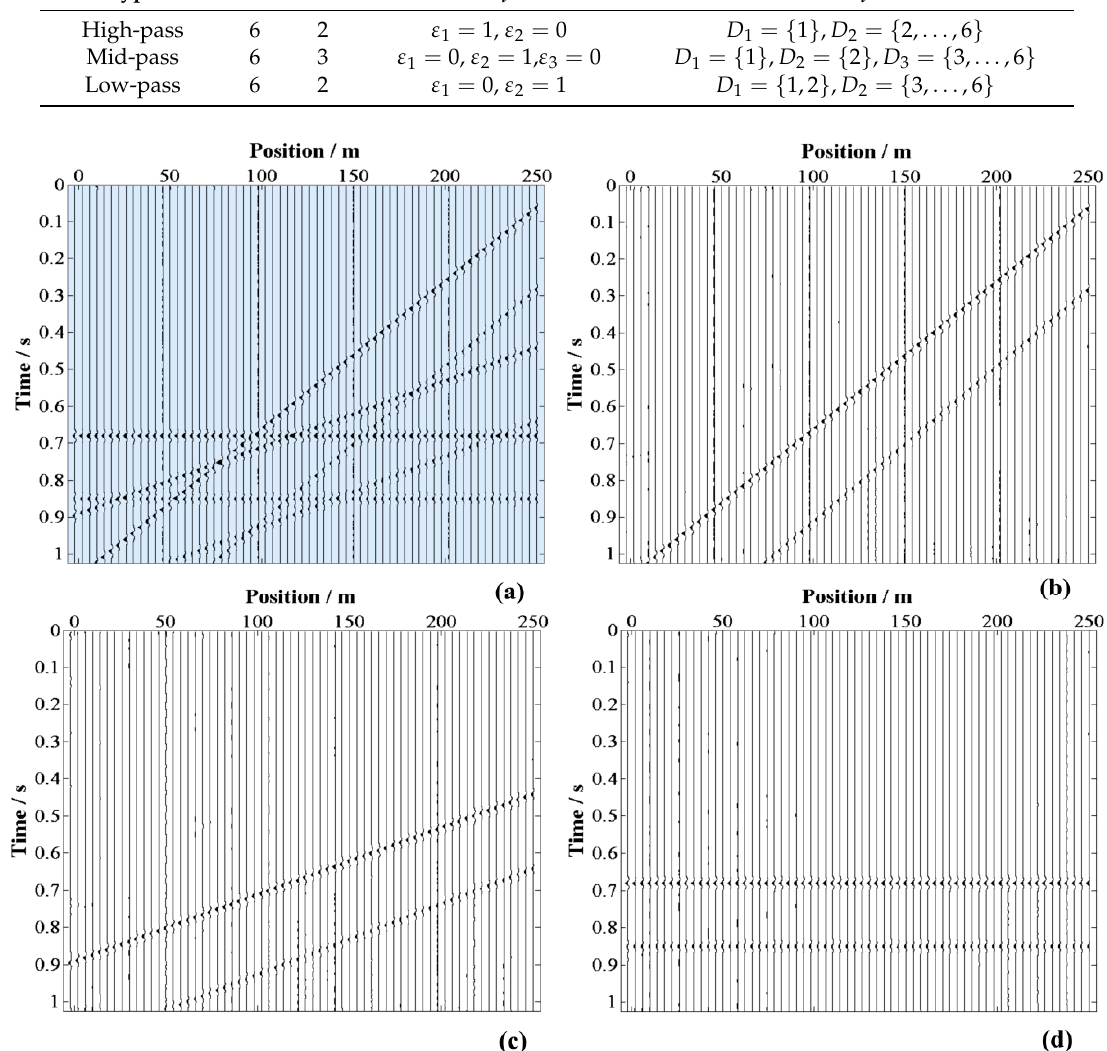
Figure 4. Demonstration of dip filter using f-x EMD. ( a ) The synthetic data, ( b ) high-pass dip filtered data, ( c ) mid-pass dip filtered data, ( d ) low-pass dip filtered data.